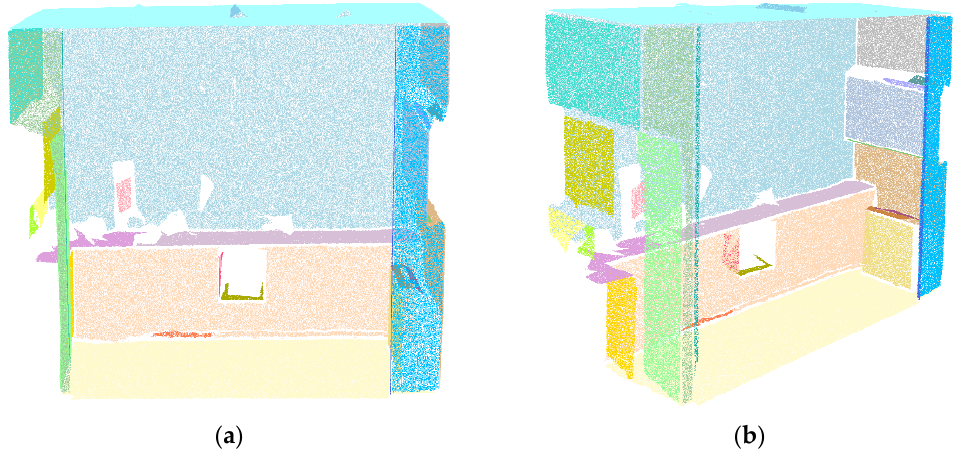
Figure 12. Pantry’s segmentation results using the region growing algorithm: ( a ) front view and ( b ) side view.